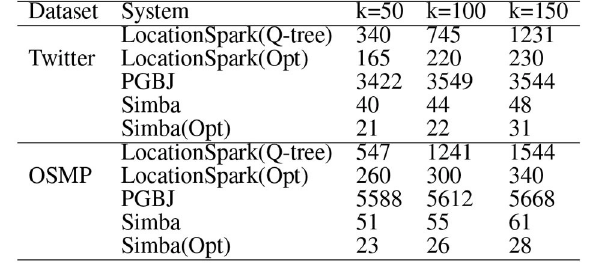
FIGURE 8 | Runtime of k NN join (in